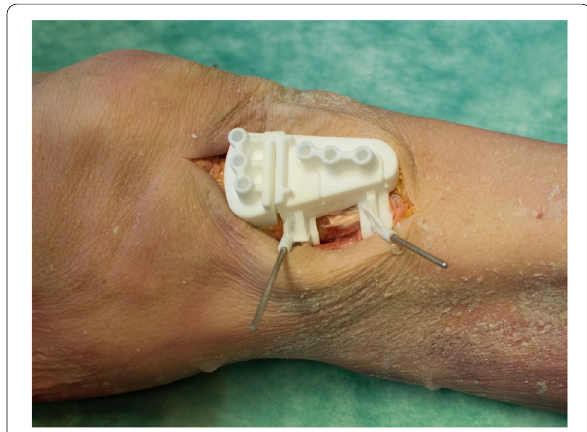
Fig. 4 3D printed cutting guide fixed with two K-wires. The soft tissue was removed from the bone at the attachment points. No further tissue was removed or released in order to simulate an in-vivo situation to the highest